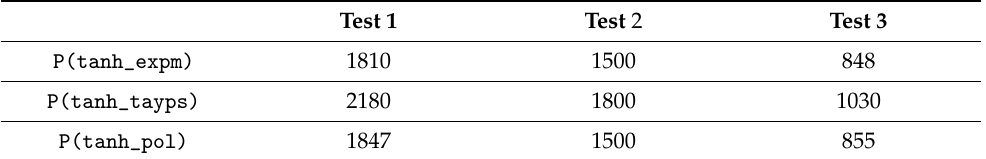
Table 4. Matrix products (P) corresponding to the tanh_expm , tanh_tayps , and tanh_pol functions for Tests 1–3. Test